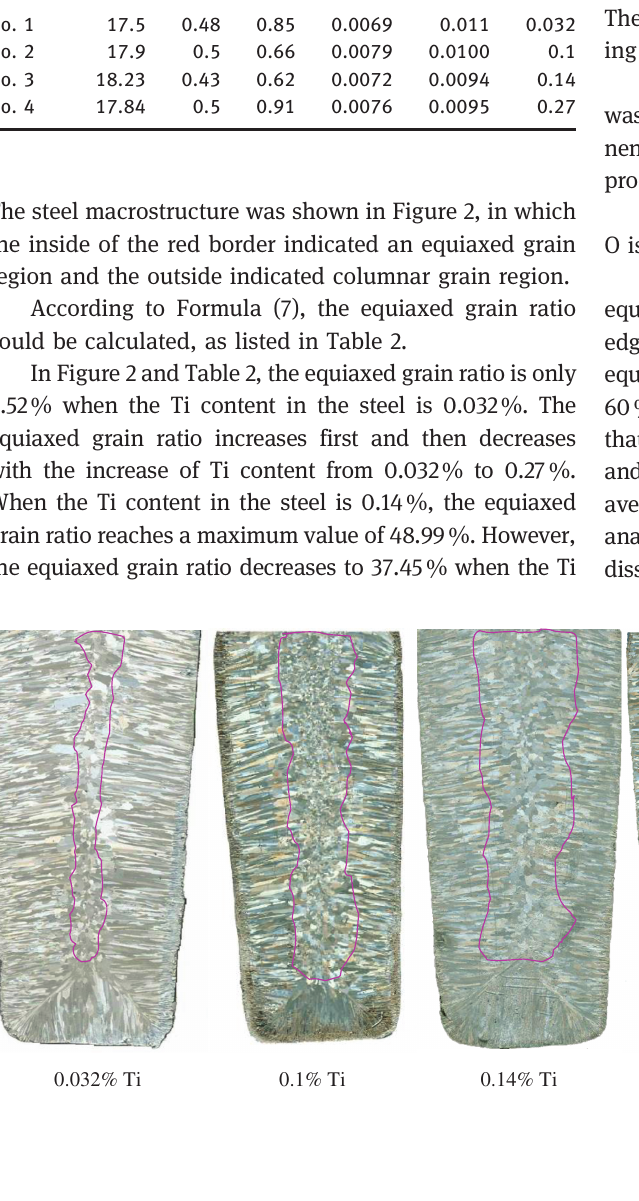
Table 1: Chemical composition of steel (%). Sample